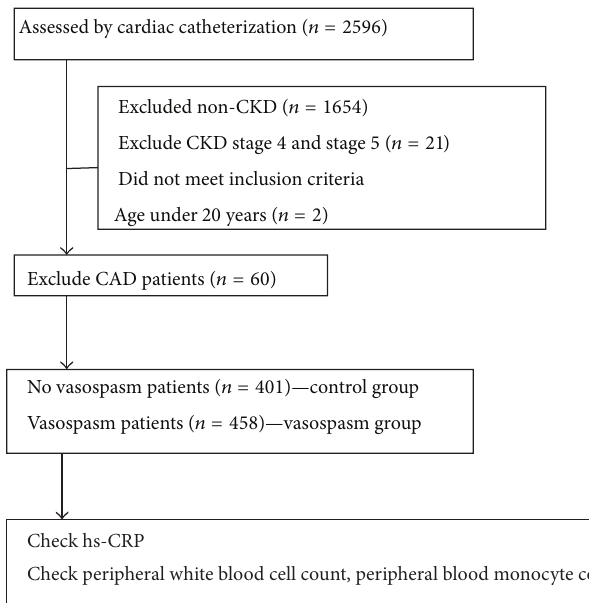
Figure 1: Flow chart indicating patient enrollment and study